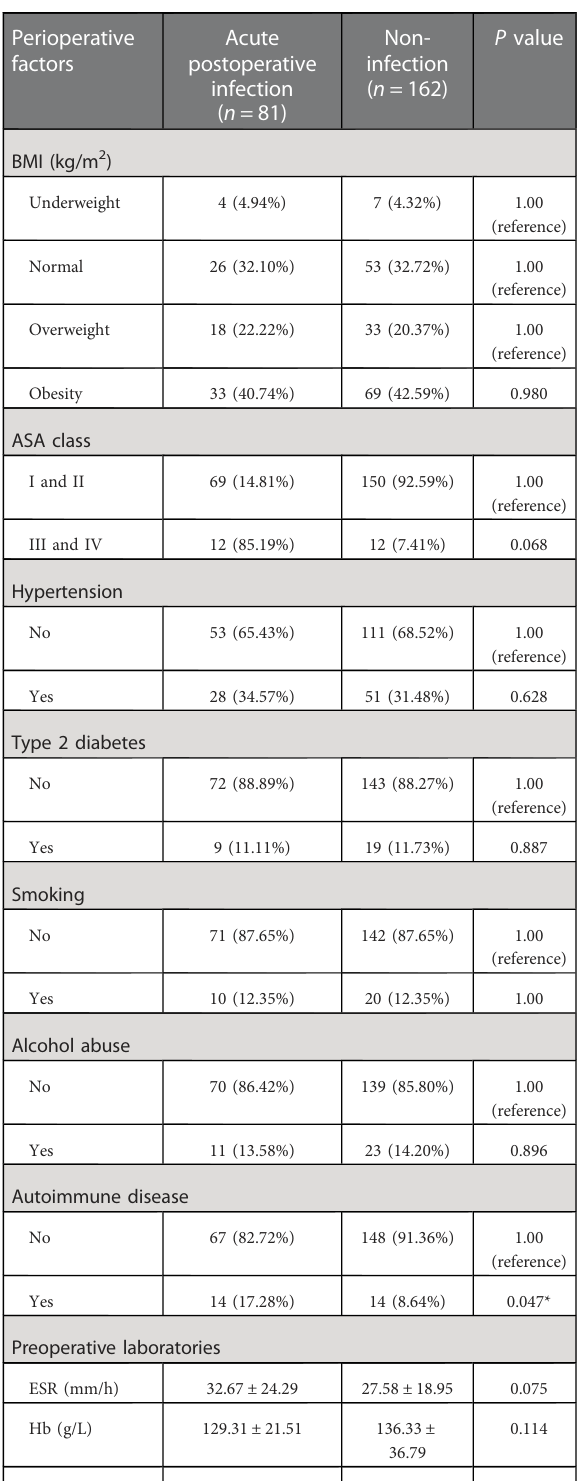
TABLE 1 Baseline characteristics of the patients and univariable analysis of risk factors for acute postoperative infection after TKA or